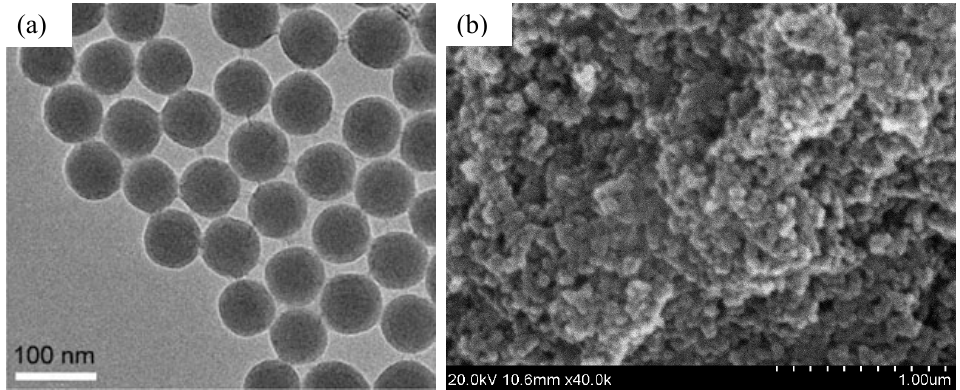
Figure 6. ( a ) TEM and ( b ) SEM image of nano-SiO 2 ·0.5H 2 O particles.